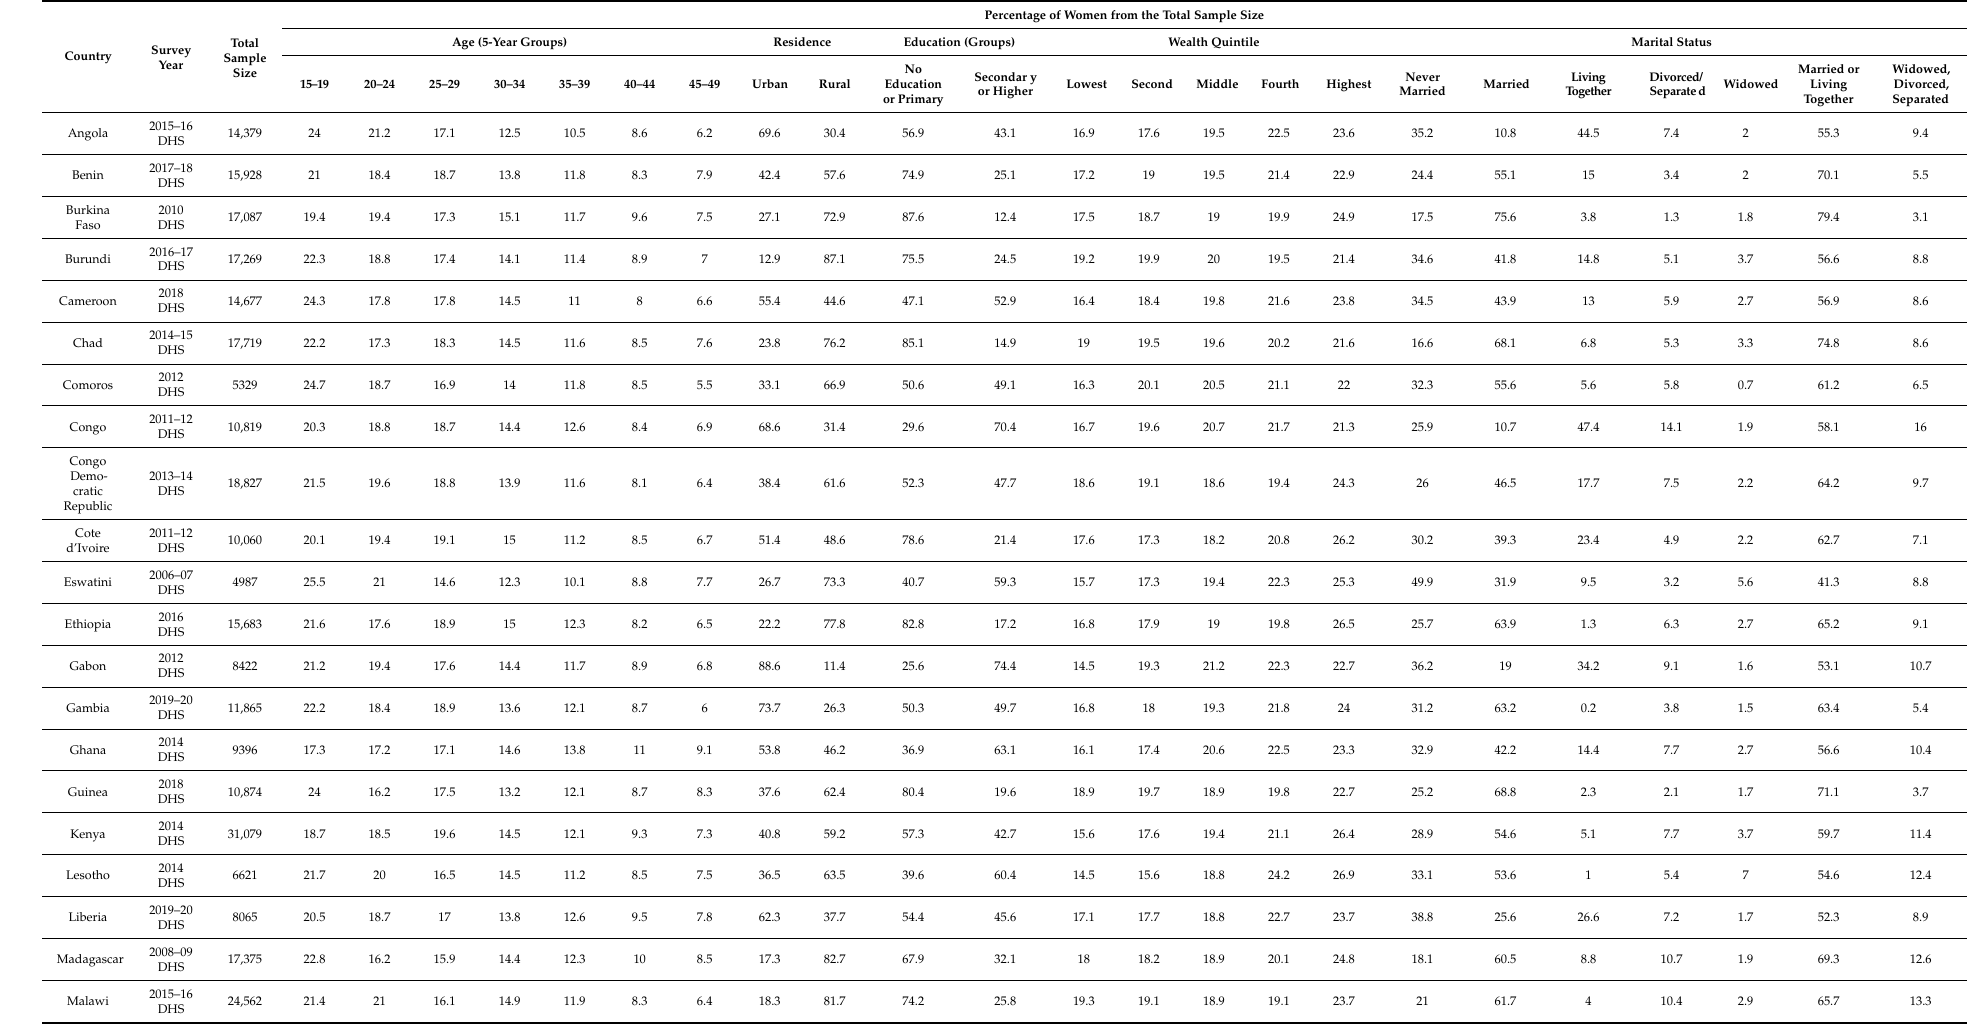
Table 1. Descriptive statistics